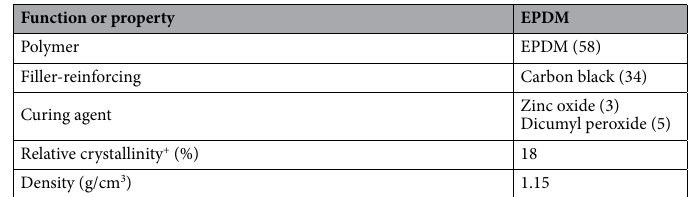
Table 1. Chemical compositions according to function and related properties of EPDM specimen. *Numbers in ( ) are weight ratios in %; + relative crystallinity (%) = 100–amorphous (%).